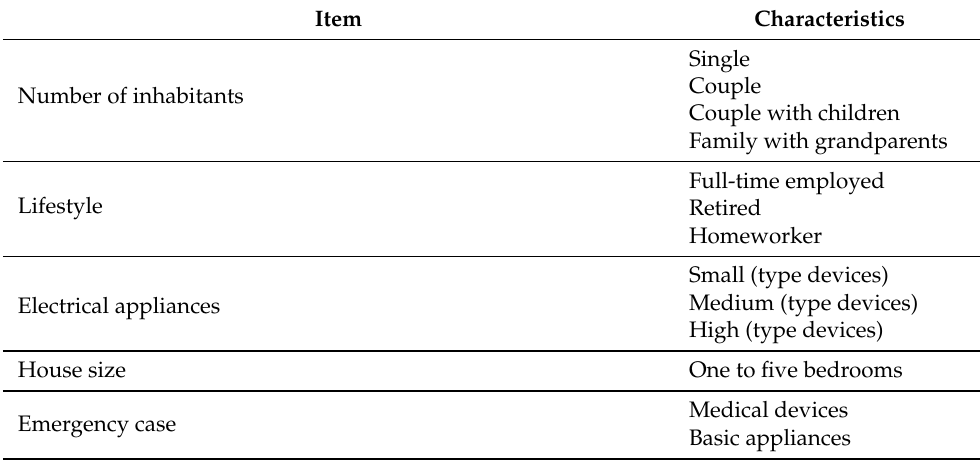
Table 2. Characteristics of residential load consumption.